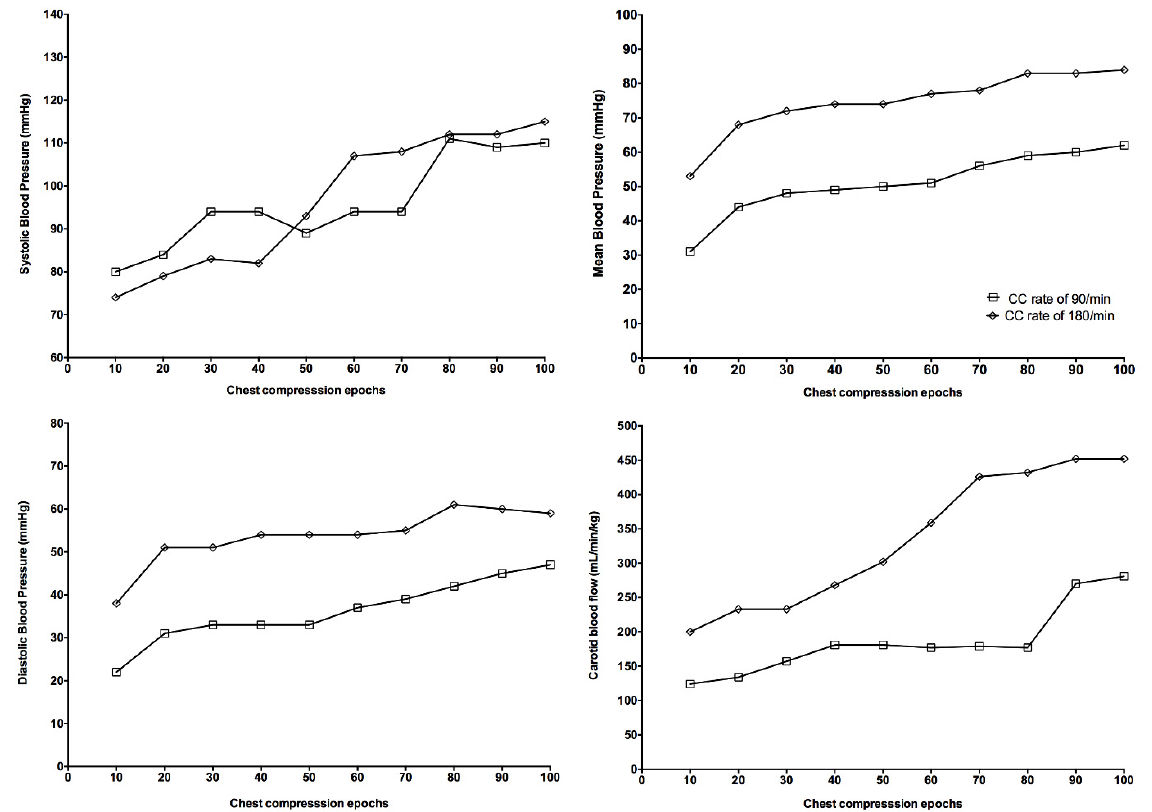
Figure 2. Changes in systolic blood pressure, diastolic blood pressure, mean blood pressure, and carotid blood flow during chest compression were divided into 10 epochs.